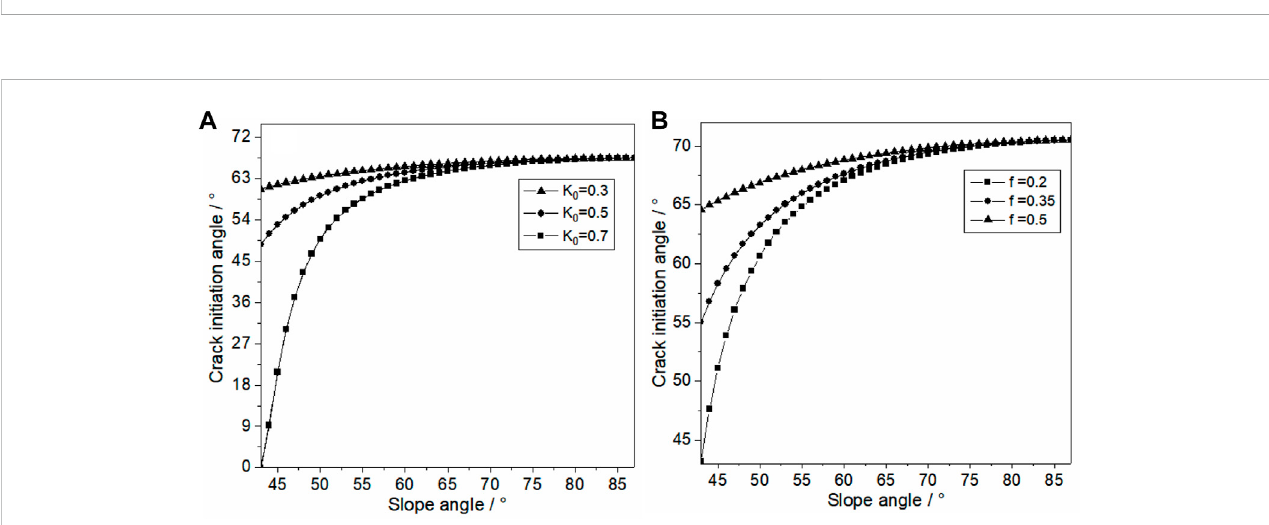
FIGURE 6 Variation in the crack initiation angle with the slope angle: (A) in fl uence of the side-pressure coef fi cient and (B) in fl uence of the side-friction coef fi cient.